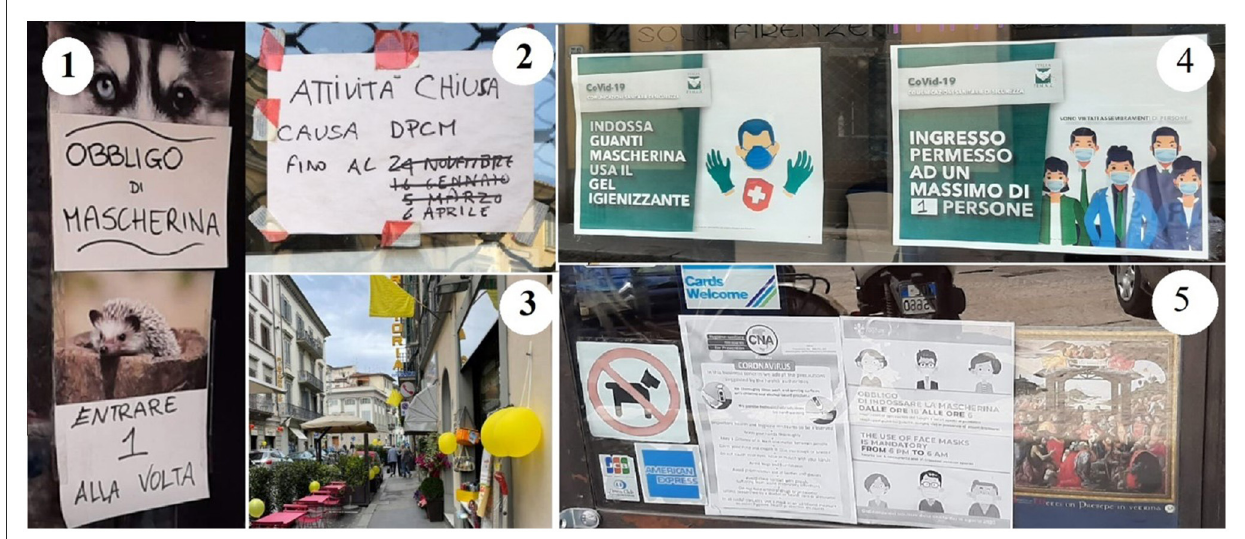
FIGURE3 Photo 1—regulatory sign personalized based on commercial activity; Photo 2—irony in the LL; Photo 3—LL semiotically connoted; Photo 4 and Photo 5—standardized regulatory